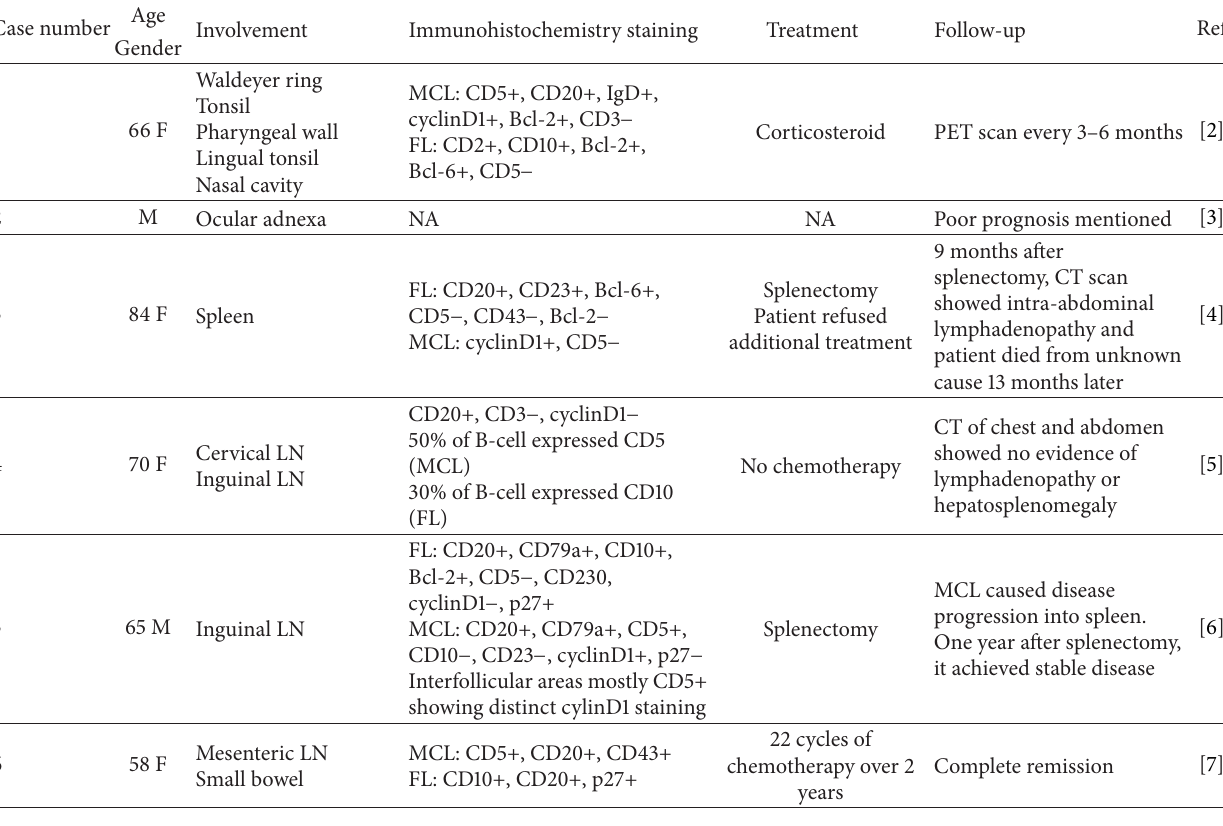
Table 1: MCL and FL composite lymphomas.